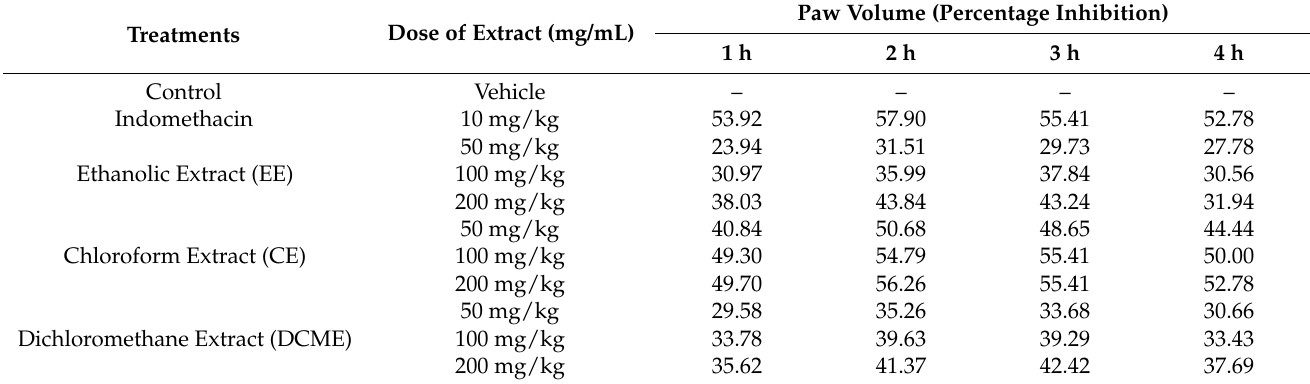
Table 8. Effect of ethanolic extract (EE), chloroform extract (CE) and dichloromethane extract (DCME) of N. triquetra on carrageenan-induced rat paw edema.